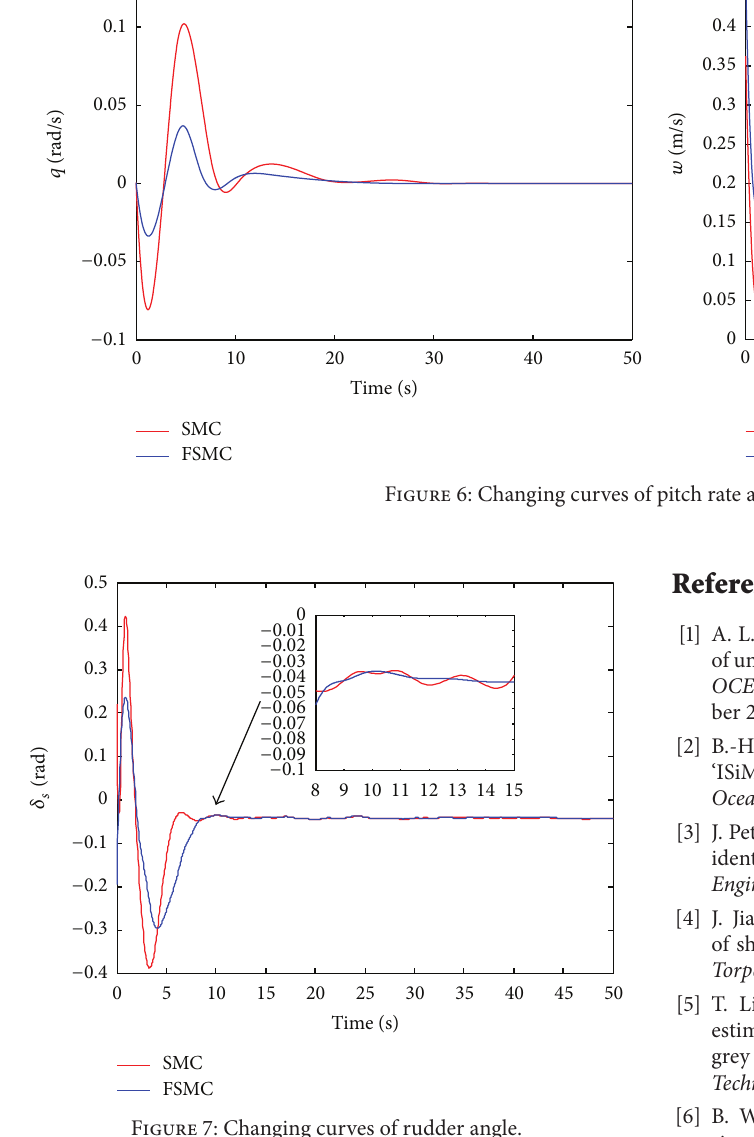
Figure 7: Changing curves of rudder